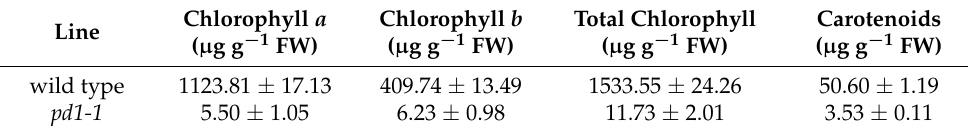
Figure 1. pd1 mutants show albino and seedling-lethal phenotypes. ( A ) Schematic diagram showing PD1 gene and the T-DNA insertion locus (bar topped by a triangle) of pd1-1 and pd1-2 mutants. (LB) Left border. (RB) Right border. ( B ) Two-week-old seedlings of wild type and pd1 mutants grown in MS medium without sucrose. Bars = 1.0 cm. ( C ) Two-week-old seedlings of wild type and pd1 mutants grown in MS medium with 3% sucrose. Bars = 1.0 cm. ( D ) Three-week-old seedlings of wild type, pd1-1 mutant and complemented plants grown in MS medium with 3% sucrose. Bars = 1.0 cm. ( E ) Identification of pd1 mutants at DNA, RNA, and protein levels. LP and RP, upstream and downstream primers for PD1 gene; LB1 and o8409, primers of T-DNA insertion for different collections. The asterisk marks a nonspecific band. Table 1. Chlorophyll and carotenoid contents in leaves of wild type and pd1 mutants.